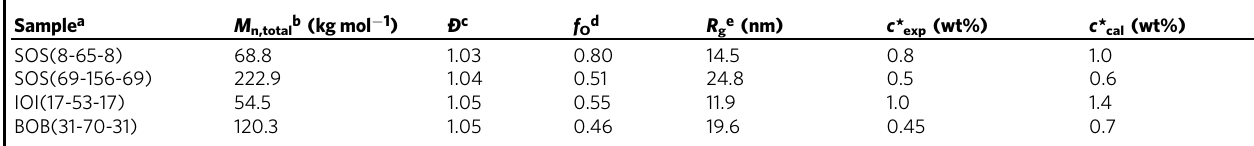
Table 1 Triblock copolymer molecular weights, dispersity values, O volume fraction, and experimentally determined and calculated overlap concentration Sample